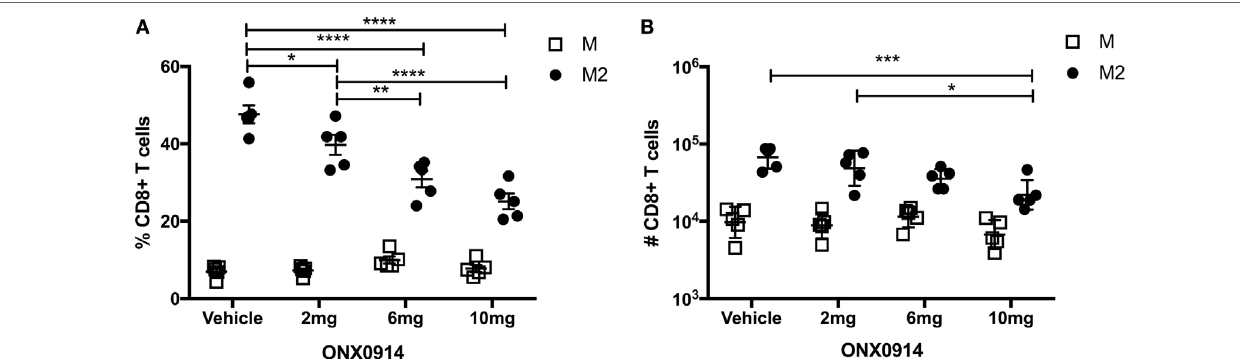
FigUre 3 | The M2 epitope is preferentially generated by the immunoproteasome. (a,B) Mice were infected with respiratory syncytial virus (RSV) and treated with the immunoproteasome inhibitor ONX-0914 or vehicle control on days 0, 2, 4, and 6 at doses of 2, 6, or 10 mg/kg. D b /M 187–195 and K d /M2 82–90 tetramers were used to quantify the frequency (a) and number (B) of M-specific and M2-specific CD8 + T cells in the lungs on day 7. **** P < 0.0001, *** P < 0.001, ** P < 0.01, * P < 0.05 by two-way ANOVA. Bars indicate mean ± SEM ( n = 5 mice/group). Data are shown from one experiment and representative of two independent